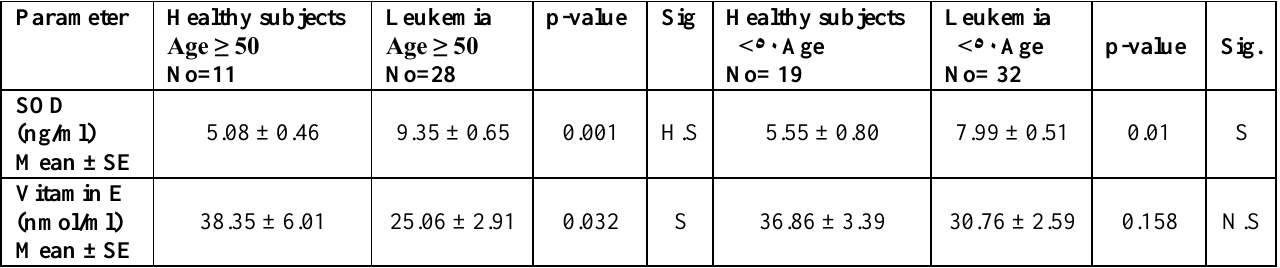
H.S: High significant, N.S: Non-significant, S: